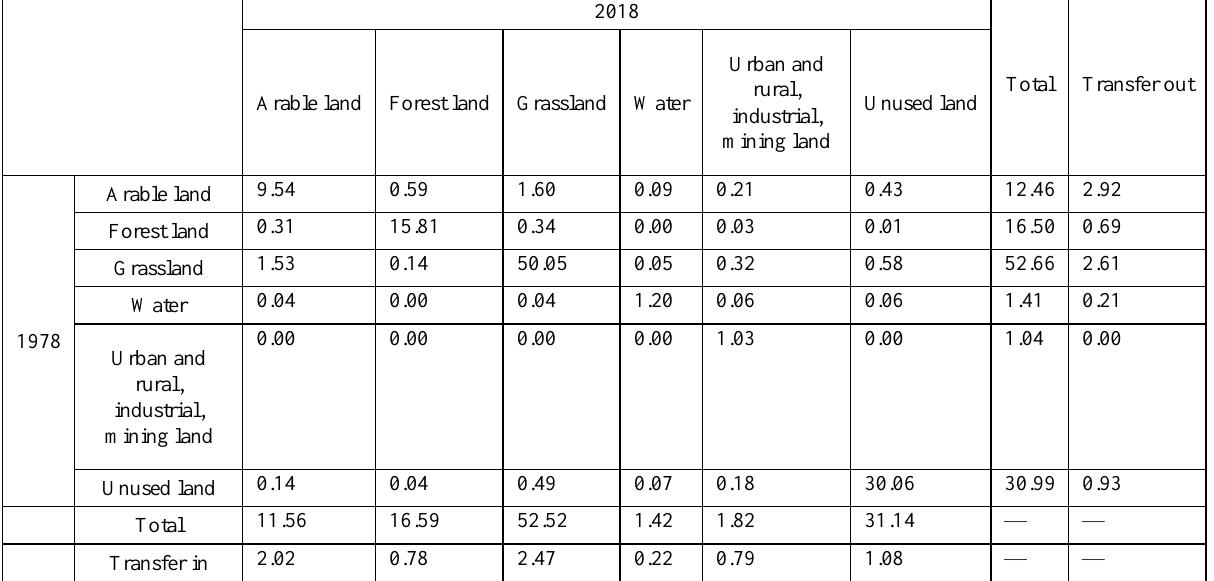
Table 2. Land Use Transfer Matrix from 1978 to 2018 (Unit: 10,000 km 2 )